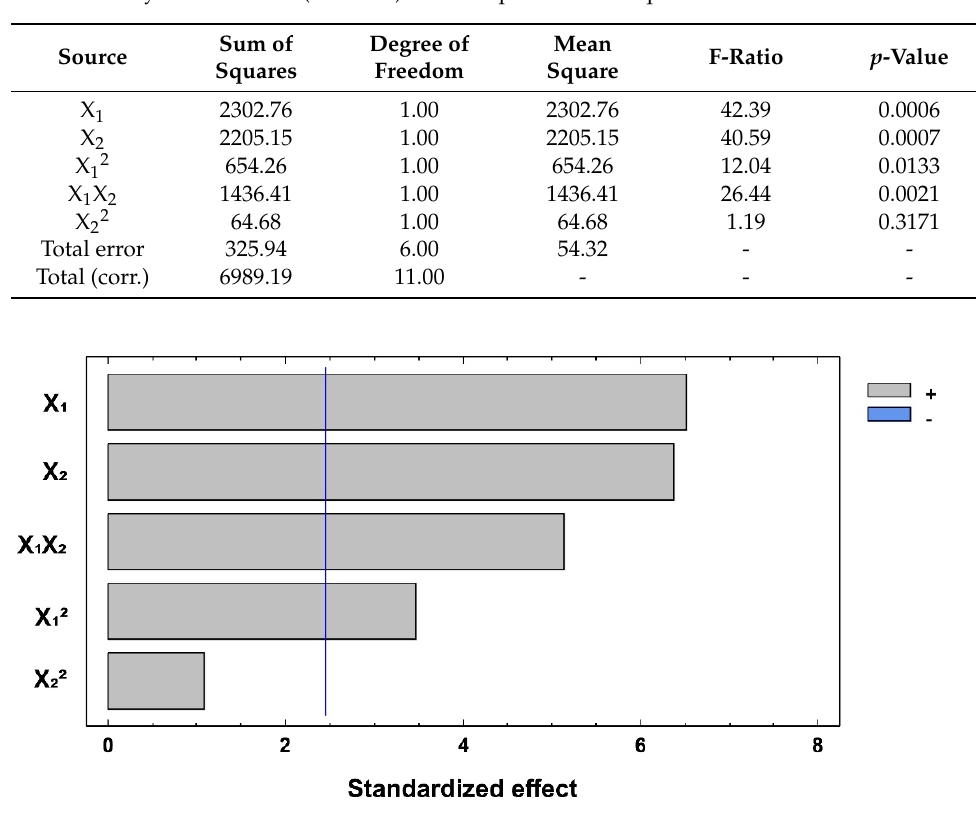
Figure 3. Real and predicted values of the removal efficiency of arsenic (III).